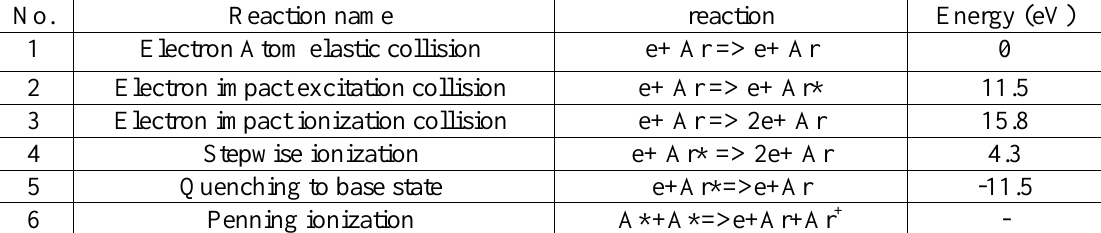
Table 1: The reactions inside the gas phase defined as follows.